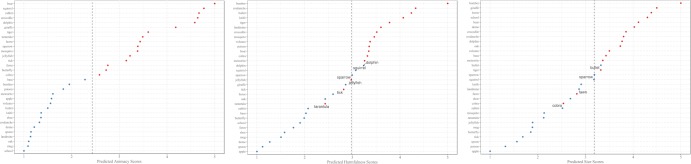
Scores for Animacy (2a), Harmfulness (2b) and Size (2c), predicted by SVR. Labelled items are words that do not conform to our qualitative binary classification.